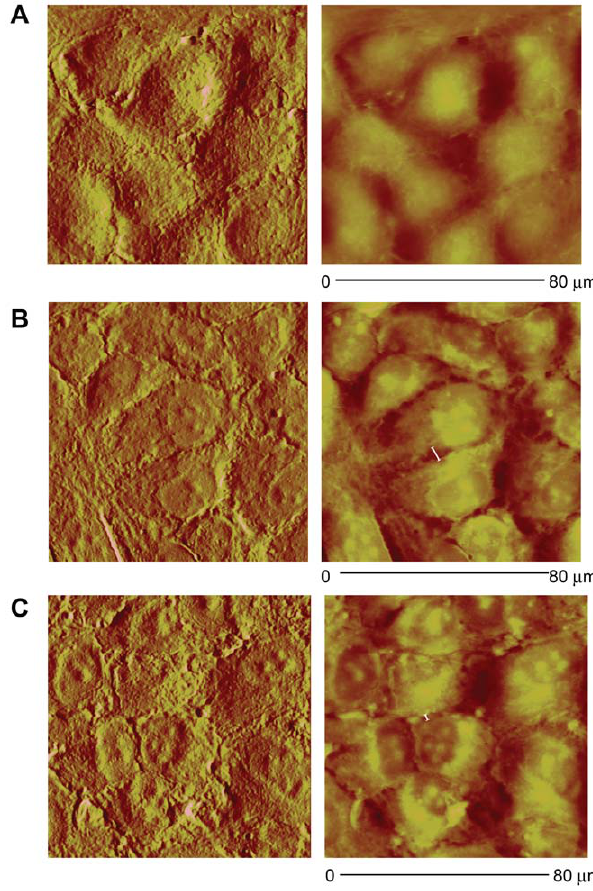
Figure 5. Endothelial surface ultrastructure is restored by FFP in an in vitro model of shock. HUVEC’s were cultured under normoxic conditions or stimulated with IL-1 b and subjected to hypoxia for four hours followed by rexoygenation and incubation for an additional four hours in 5% lactated Ringers (LR), or 5% FFP and compared to normoxia. Cell surface ultrastructure was assessed using atomic force microscopy, 80 m m area scanned for all images. The deflection (left) and corresponding height (right) topographic images are shown from representative images of three separate experiments for each group. Normoxic controls (A) demonstrate no gaps between cells whereas areas of thinning between cell junctions are seen after LR (B) but reduced by FFP (C). Gaps are indicated by white